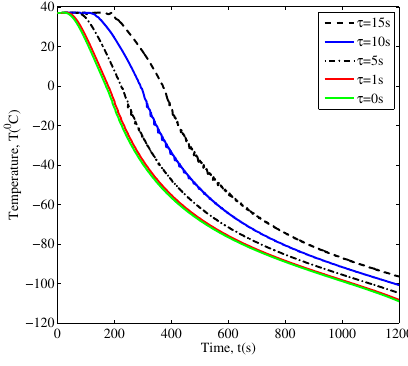
Figure 6. Temperature history at the point x = 0 . 01 m for the time relaxation value τ = 15 s , τ = 10 s , τ = 5 s , τ = 1 s , τ = 0 s .